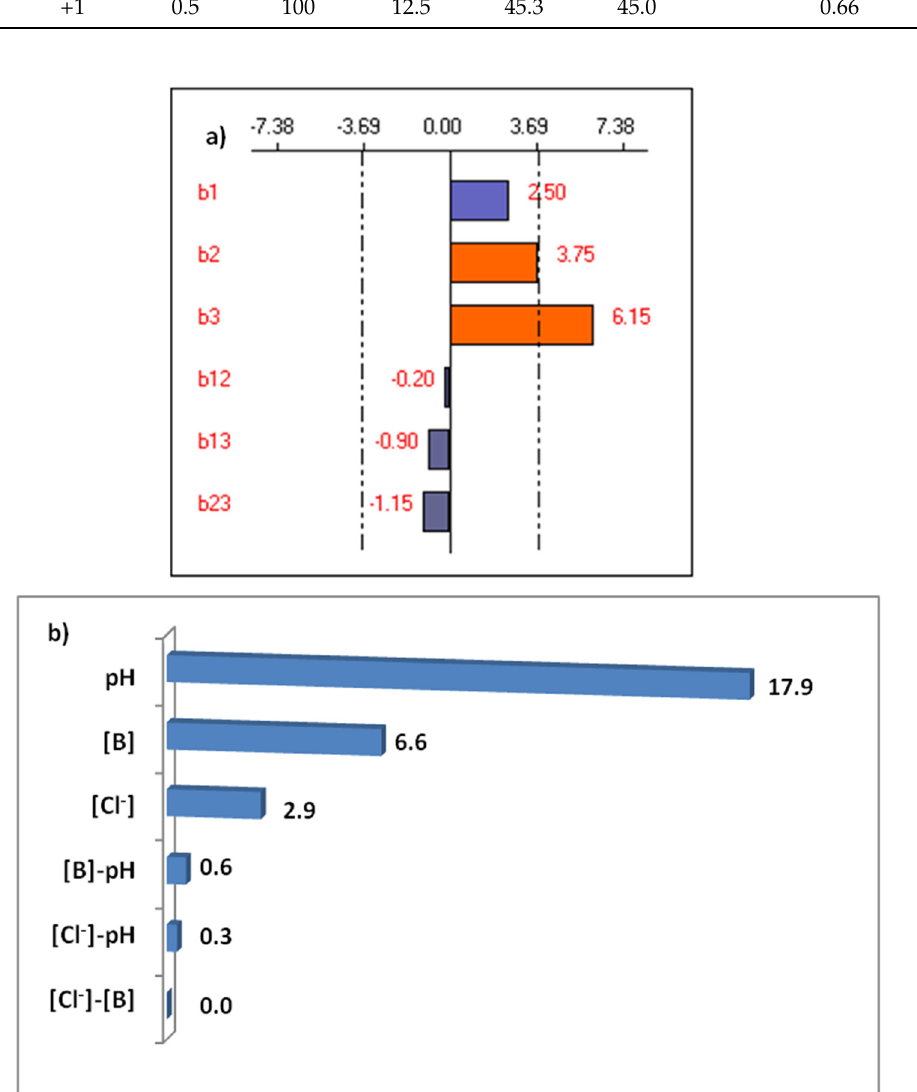
Figure 5. ( a ) Graphical analysis of the removal of boron, ( b ) Pareto effect.